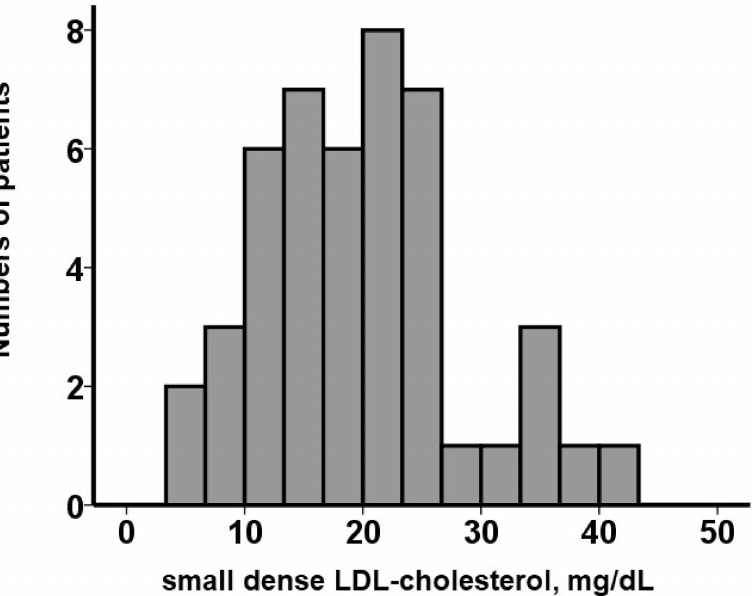
Figure 1. Distribution of small dense LDL cholesterol at index discharge ( N = 46). LDL, low-density